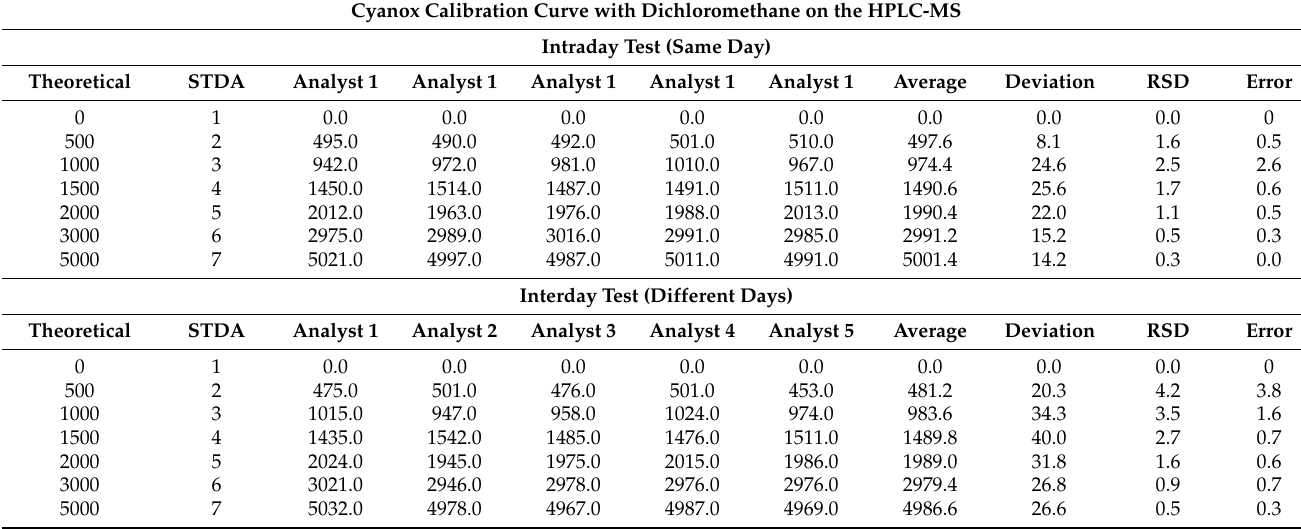
Table 1. Tabulation of data for repeatability and reproducibility of standards in HPLC-MS.